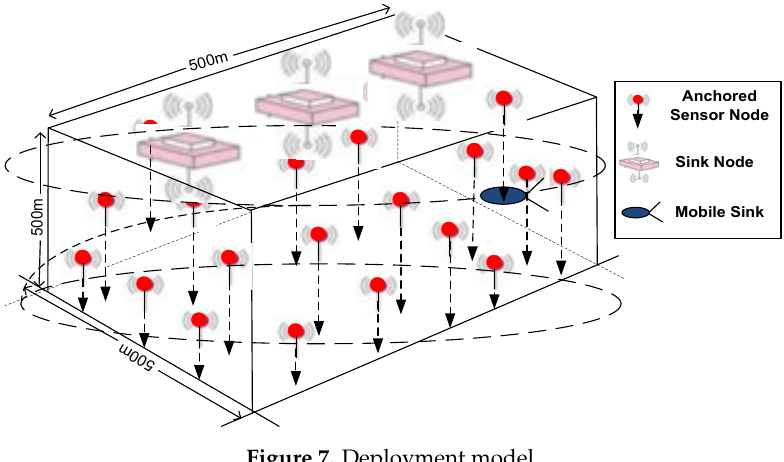
Figure 7. Deployment model.